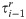
Real and artificial hashtag spike trains.(a) As an illustration of different hashtag spike trains representing different types of hashtag propagation of the data set. (b) Merging hashtag spike trains from the real data. The black spikes describe that only one activity is counted if multiple activities occur at the same time. (c) Randomization procedure by randperm (Matlab). T contains full hashtag activity of the data set. The randperm gives a matrix with p elements, p unique independent numbers out of T, and constructing random time series …, τi−1r, τir, τi+1r, … from full hashtag activity matrix T. (d) The resultant artificial hashtag spike train.